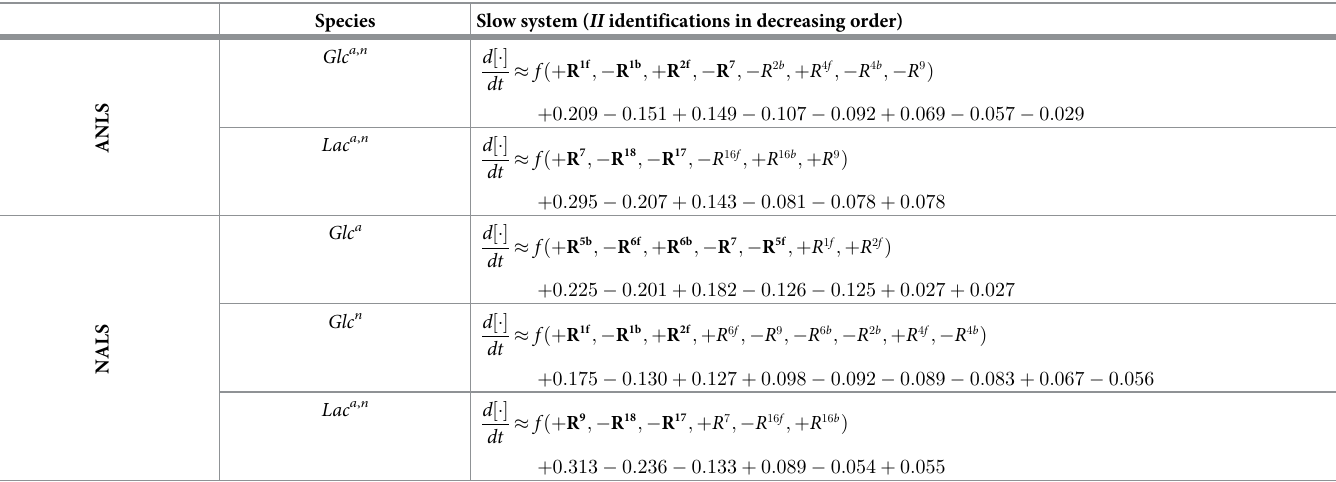
Identification of the reactions contributing the most to the slow evolution of the Glc a , Glc n , Lac a and Lac n by II , during the neuronal activation for the ANLS (top) and the NALS (bottom) cases; t = 1100 s . Reactions in bold denote contributions larger than 10%. Only the largest contributions are displayed. Numbers denote the corresponding II